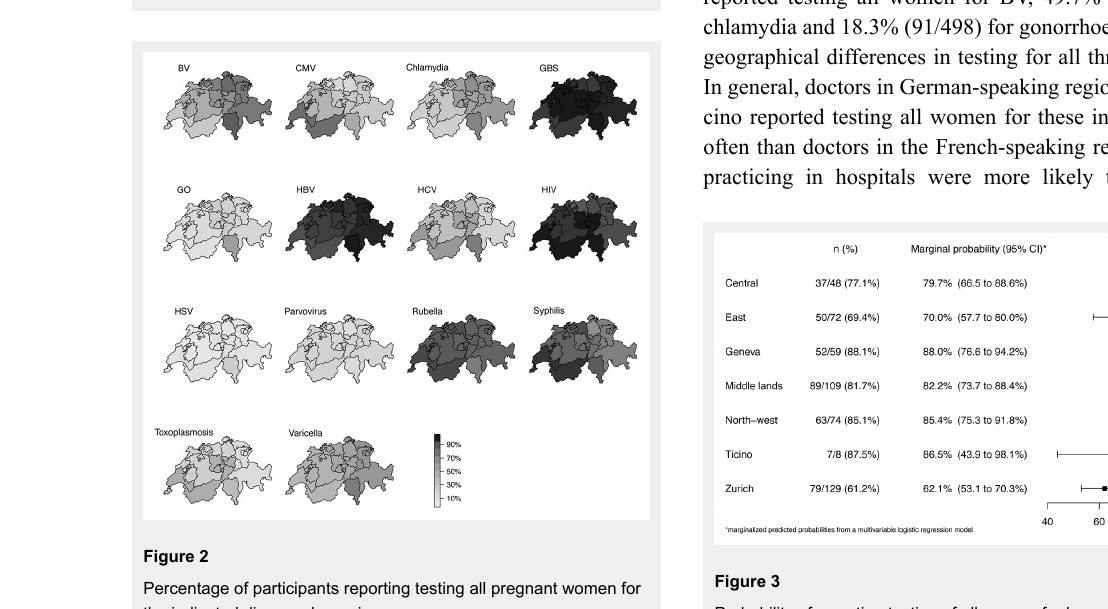
Testing practice for each infection, percentage of respondents reporting each practice. None = no testing for this infection; symptoms = test only women with symptoms; risk = test only women with specific risk factors; demand = test women who request it; all = test all women for this infection BV = bacterial vaginosis; CMV = cytomegalovirus; GBS = group B streptococcus; GO = gonorrhoea; HBV = hepatitis B virus; HCV = hepatitis C virus; HIV = human immunodeficiency virus; HSV, herpes simplex virus